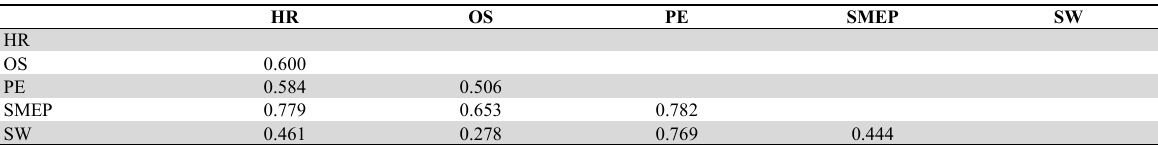
Heterotrait Monotrait Ratio HR OS PE SW HR OS